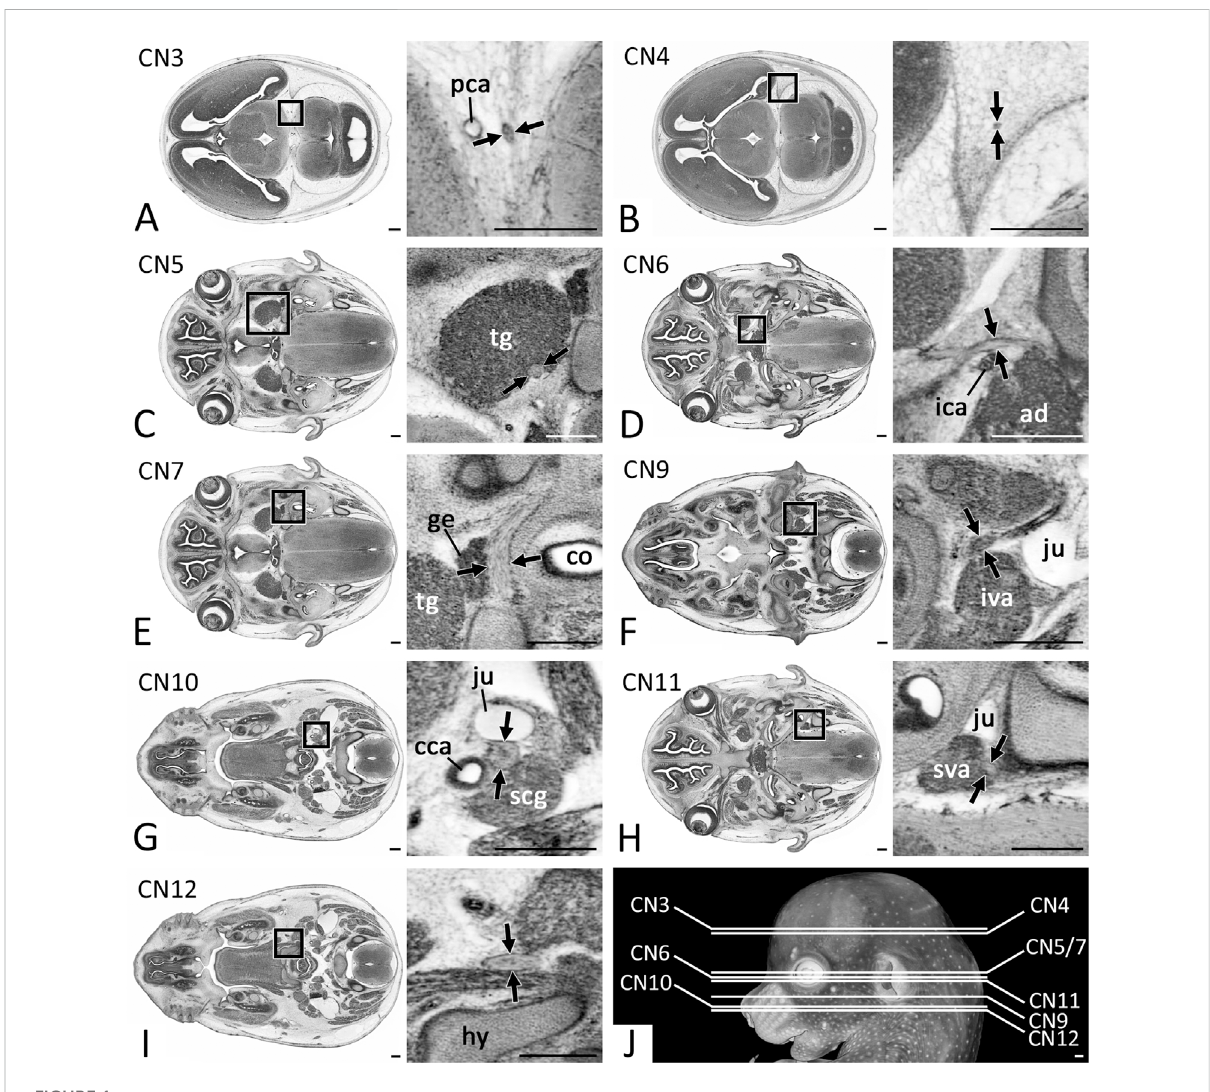
FIGURE 1 Positions of CN measurements (Arrows) in 2D axial HREM sections (A) CN3 measured after its rootlets form a solid nerve (B) CN4 measured within the forming dura mater (C) Motoric part of CN5 measured at its widest diameter within the trigeminal ganglion (tg) (D) CN6 measured next to the internal carotid artery (ica) (E) CN7 measured next to the geniculate ganglion (ge) (F) CN9 measured caudal to its inferior ganglion (G) CN10measuredcaudaltoitsinferiorganglion (H) CN11measuredatitswidestdiameternexttothesuperiorganglionofthevagusnerve(sva) (I) CN12 measured lateral to the forming hyoid bone (hy) (J) Overview of the level of measurement positions. Abr. ad = adenohypophysis, cca = common carotid artery, co = cochlea, iva = inferior vagus ganglion, ju = jugular vein, scg = superior cervical ganglion. Scale bars = 250